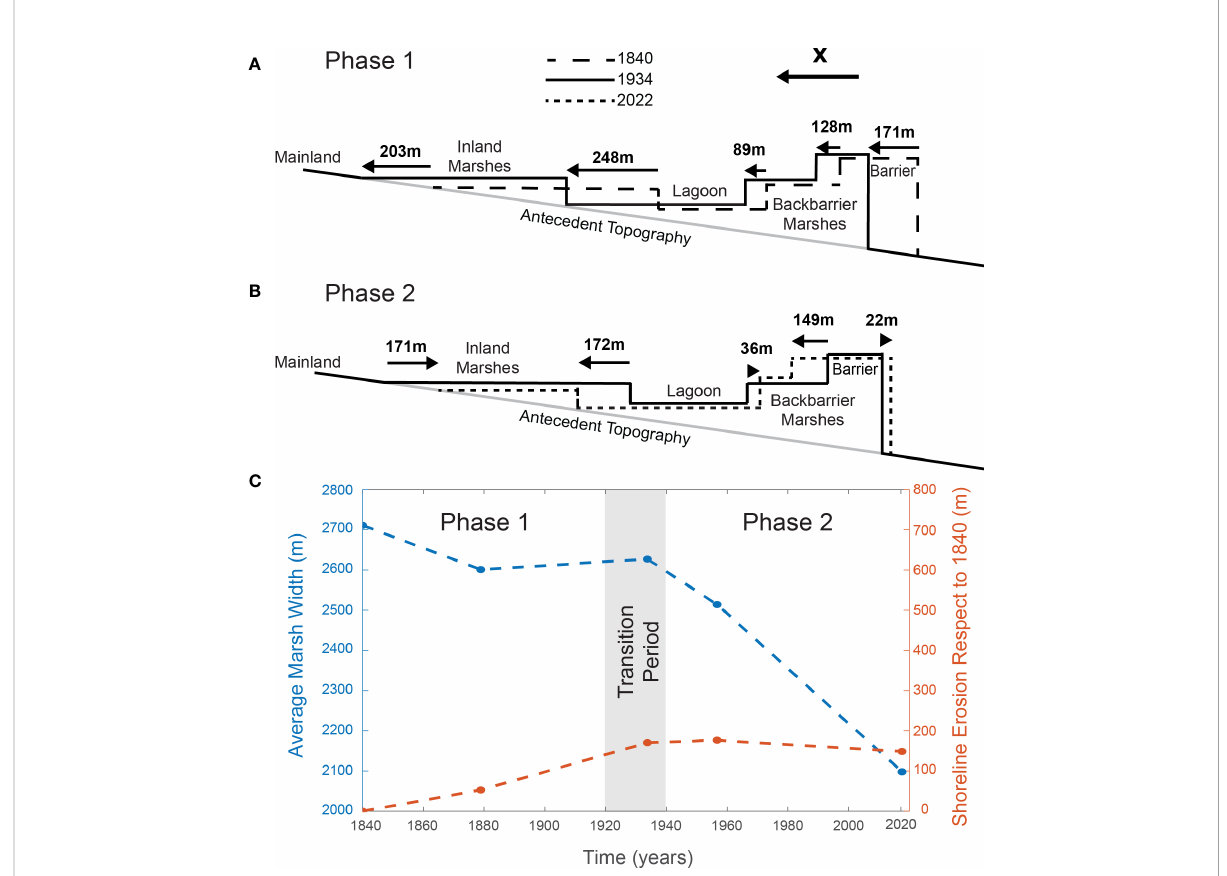
FIGURE 2 Long Beach Island cross-shore evolution between (A) 1840 and 1934, and (B) 1934 and 2022. (C) Average marsh width and ocean shoreline location respect to 1840 over